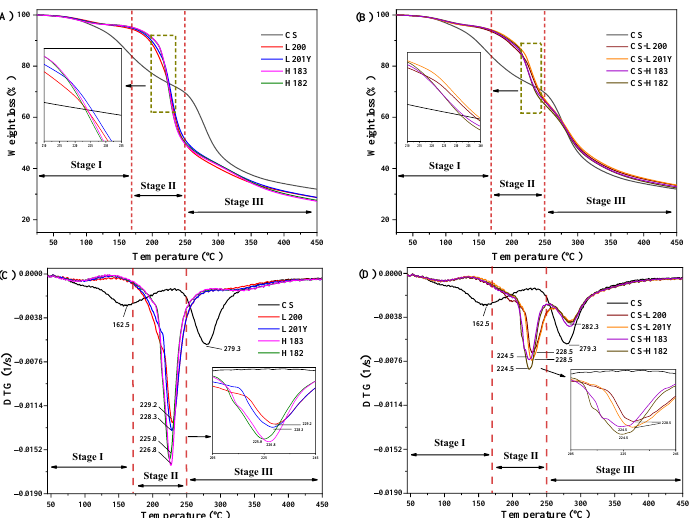
Figure 5. TGA curves and the relative derivative curves of different monolayer and bilayer films. The subfigures of A-D were enlarged interpretation of the intersection regions of the curves of stage II in thermal